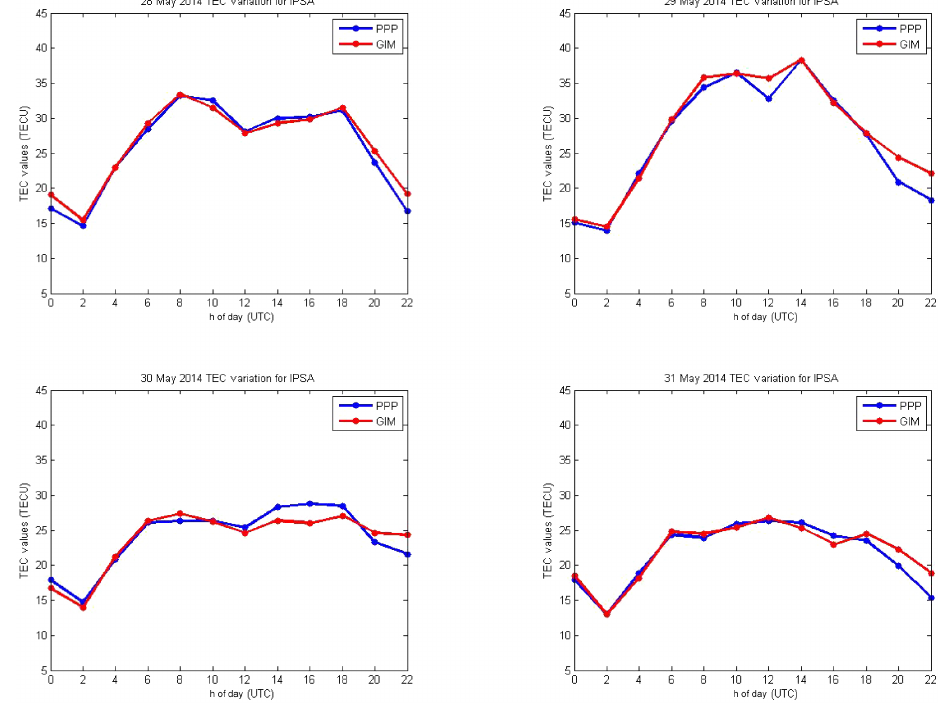
Figure 6. Representation of PPP and GIM-TEC values for the IPSA station. Table 2. AYVL station 2h resolution average TEC data. Time Average Standard deviation Average Standard deviation (UTC) (PPP-TEC) (PPP-TEC) (GIM-TEC) (GIM-TEC) (TECU) (TECU) (TECU)